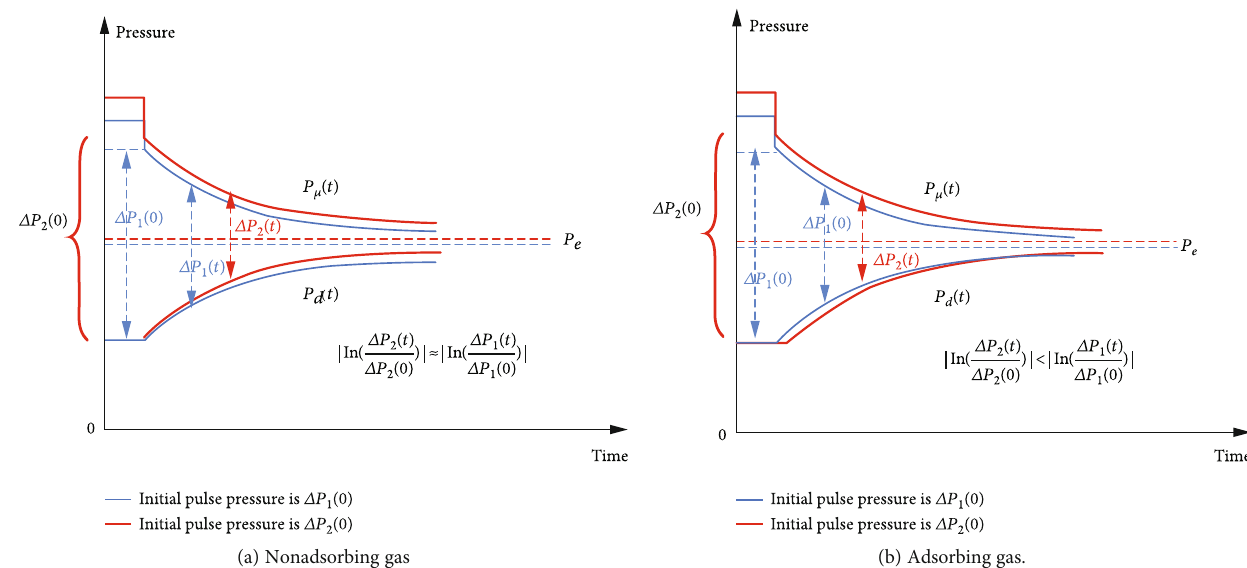
Figure 10: Changes of pressure for nonadsorbing and adsorbing gases under di ff erent pulse pressures in the transient